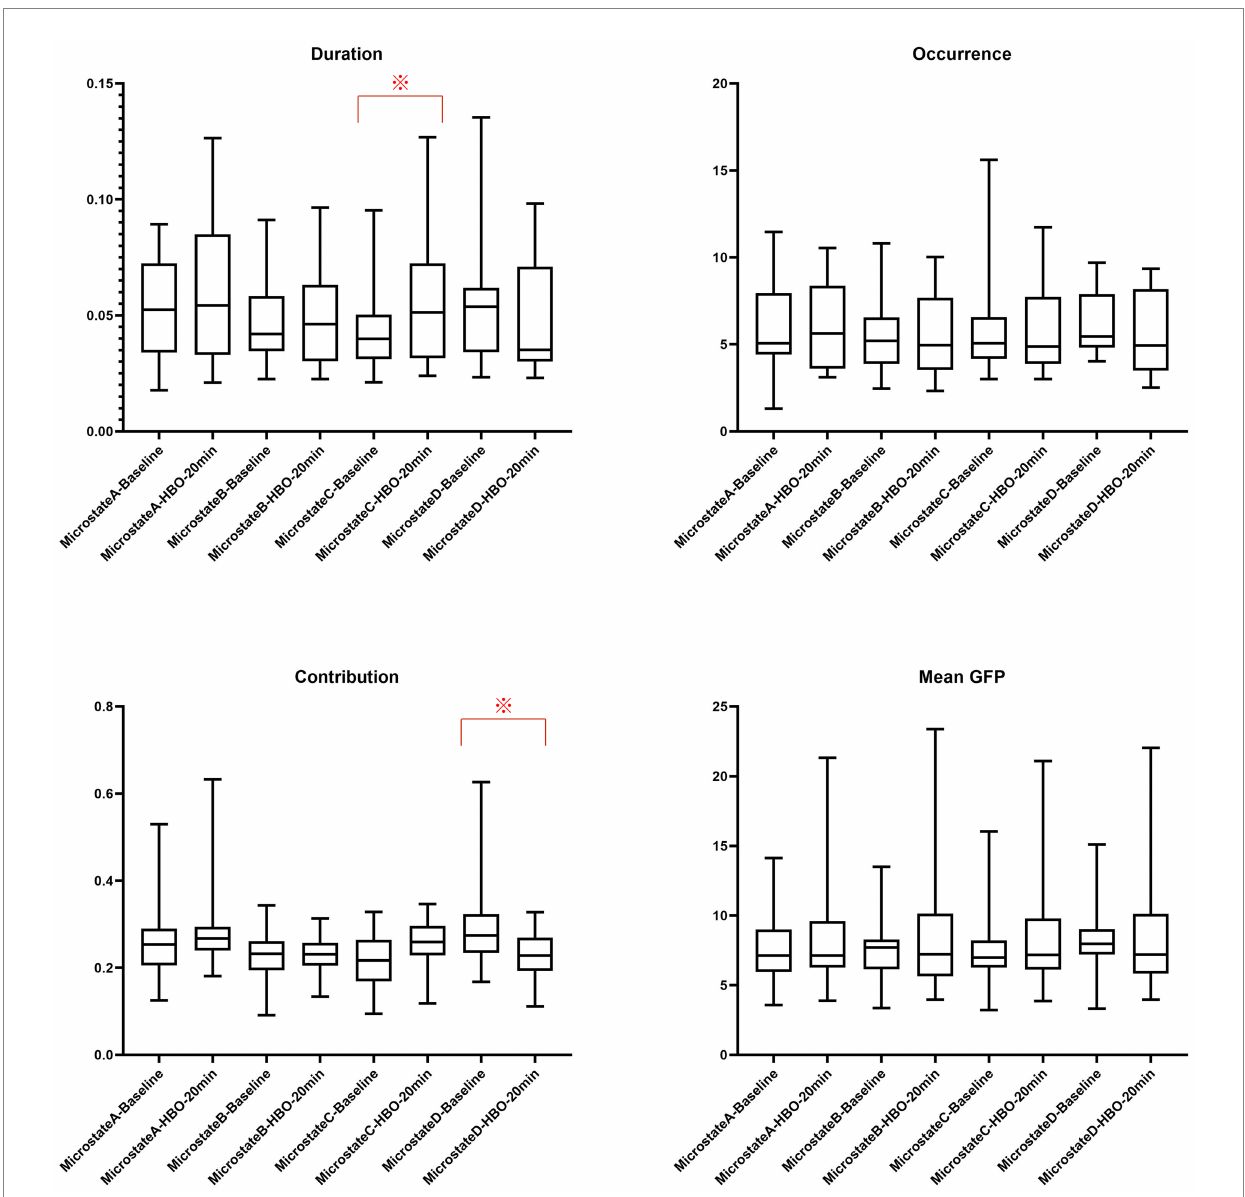
FIGURE 5 EEG microstate duration, occurrence, contribution and mean GFP analysis results of DOC patients (17 cases) with CRS-R ≥ 8. ※ Indicates the t -test result was significant ( p <